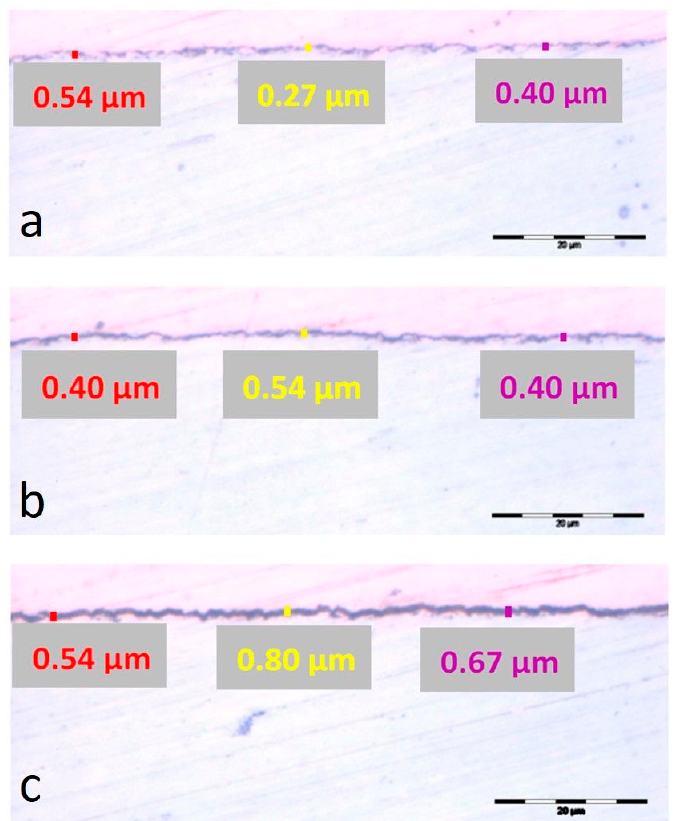
Figure 3. Optical micrographs for oxide layer thickness of oxidized samples for 720 h ( a ), 1440 h ( b ), and 2160 h ( c ) in water at 550 °C and 250 atm. (×500 magnification).